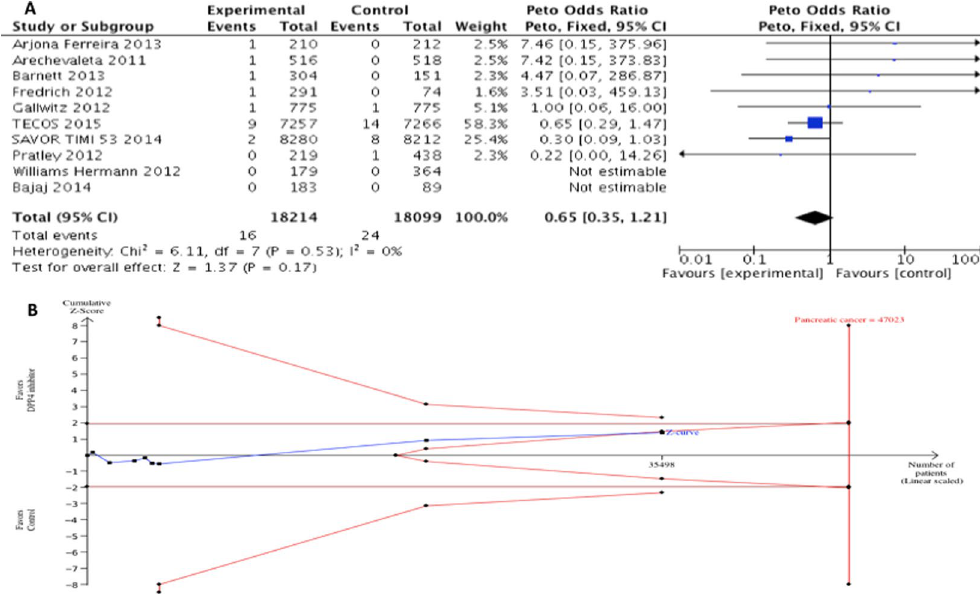
Figure 2. ( A ) Forest plot for association between DPP-4 inhibitors and pancreatic cancer; ( B ) TSA for pancreatic